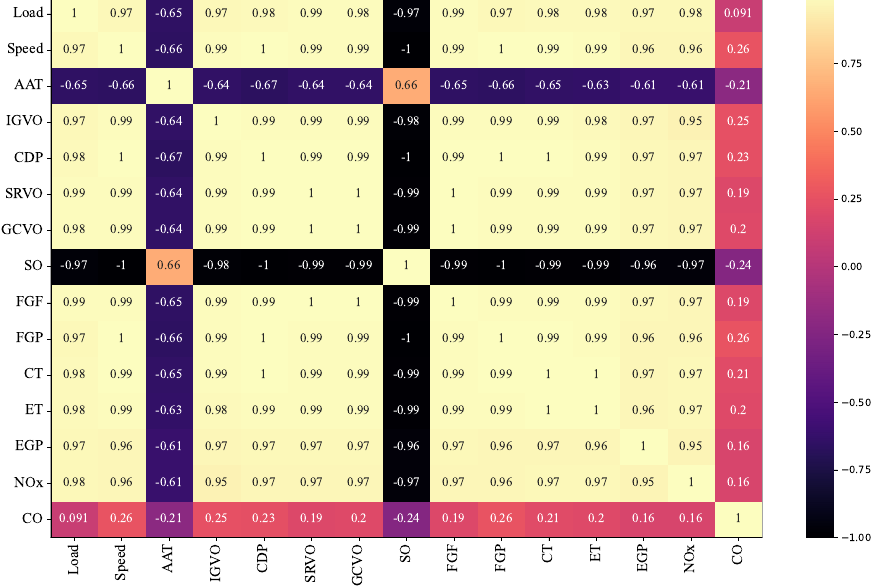
Figure 7. Parameters correlation